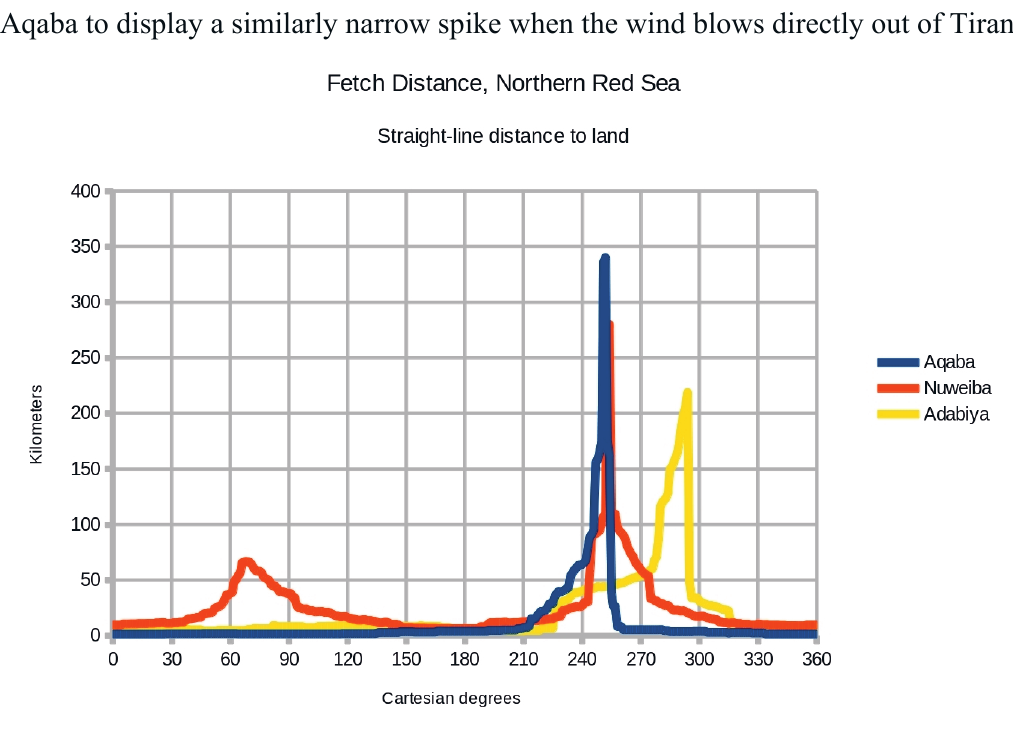
Figure 2. Fetch distance by compass direction at Aqaba; Nuweiba; and Adabiya (10 km southwest of Suez). 0° and 360° = east; 90° = north; 180° = west; 270° = south. The fetch is defined as the straight-line distance across water before hitting